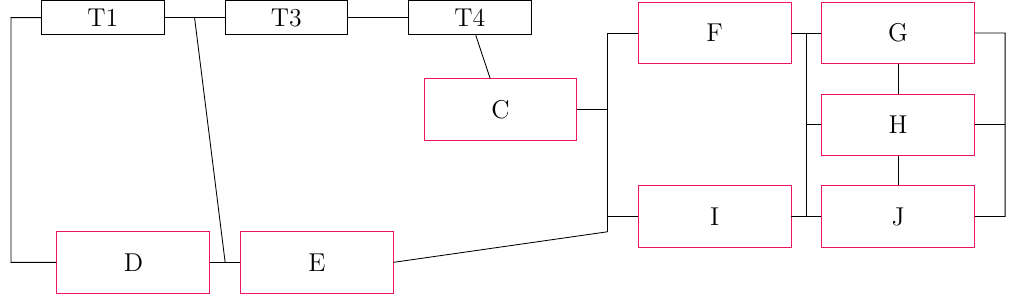
Figure 2. Aggregated representation of the apron at Stuttgart Airport.